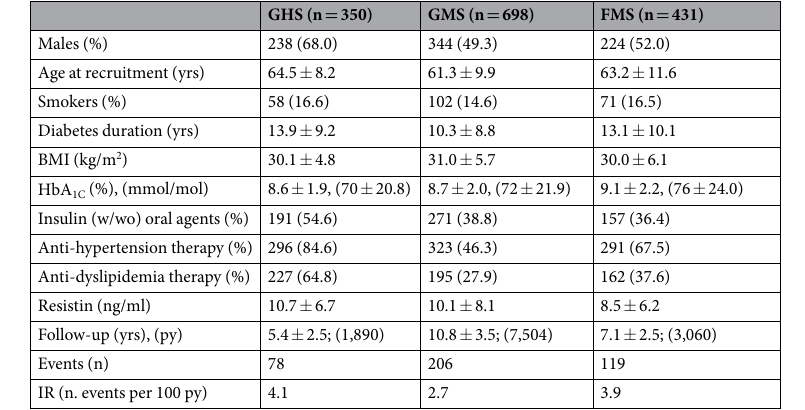
Table 1. Clinical characteristics of study patients. Continuous variables were reported as mean ± SD whereas categorical variables as total frequency and percentages. GHS: Gargano Heart Study; GMS: Gargano Mortality Study; FMS: Foggia Mortality Study; BMI: body mass index; HbA1c: glycated haemoglobin; IR: incidence rate of all-cause death events; py: person-years.